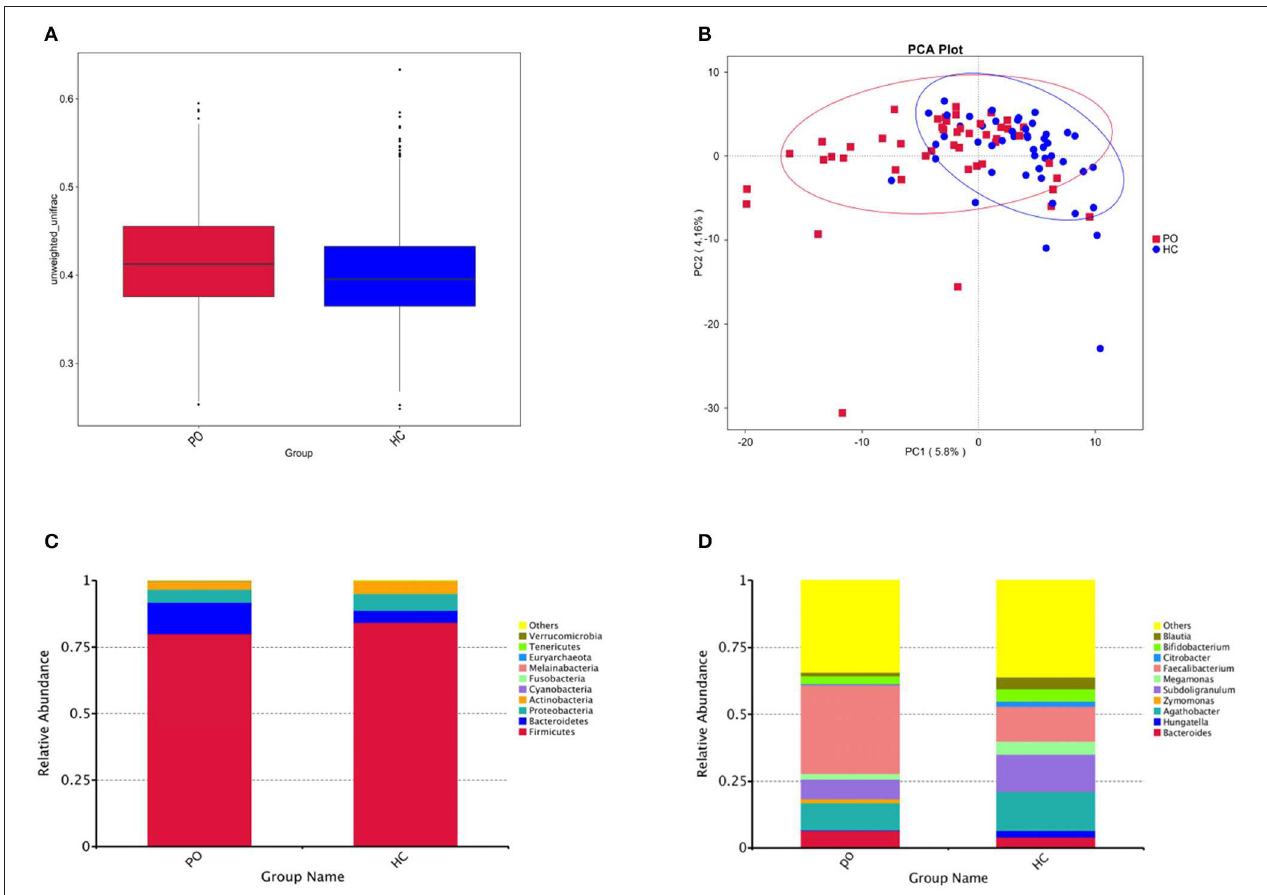
FIGURE 2 | (A) Box chart based on Beta diversity showed significant difference between the two groups. Abscissa represents Weighted Unifrac, Box plot response median, degree of dispersion, maximum, minimum, outliers. (B) Principal Component Analysis (PCA), the abscissa represents the first principal component, the percentage represents the contribution of the first principal component to the sample difference; the ordinate represents the second principal component, and the percentage represents the contribution of the second principal component to the sample difference; each point in the graph represents A sample (PC1 = 5.8%; PC2 = 4.16%) (Blue, HC; Red, PO). Cylindrical accumulation Map of relative abundance of species at Phylum level (C) and Genus level (D) . The abscissa is grouping information; the ordinate represents Relative Abundance; others represents the sum of the relative abundances of all the phylums except the 10 phylums in the